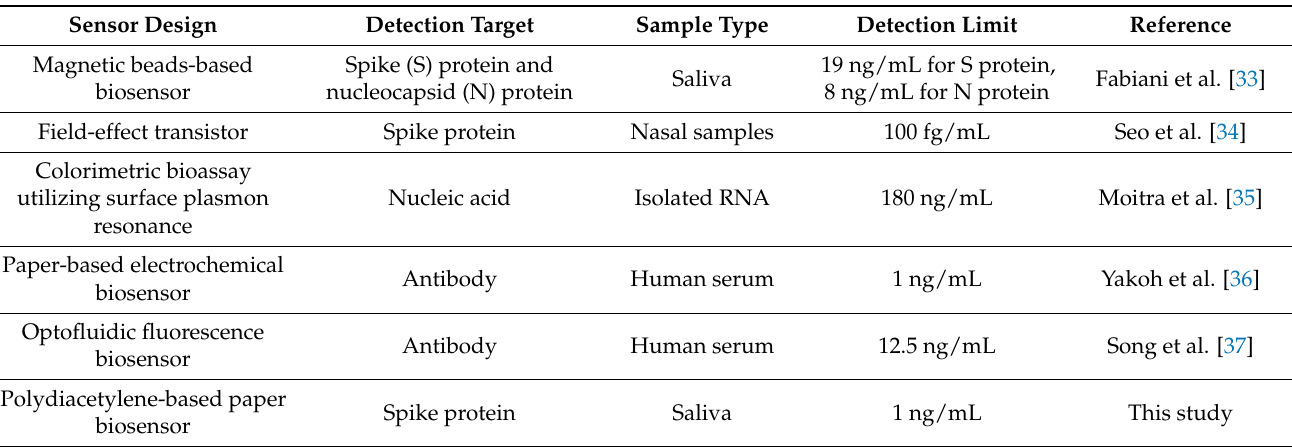
Table 2. Comparison of active biosensors for SARS-CoV-2 detection. The sensor design, detection target, sample type, and detection limit are presented for various biosensors designed to detect SARS-CoV-2 in